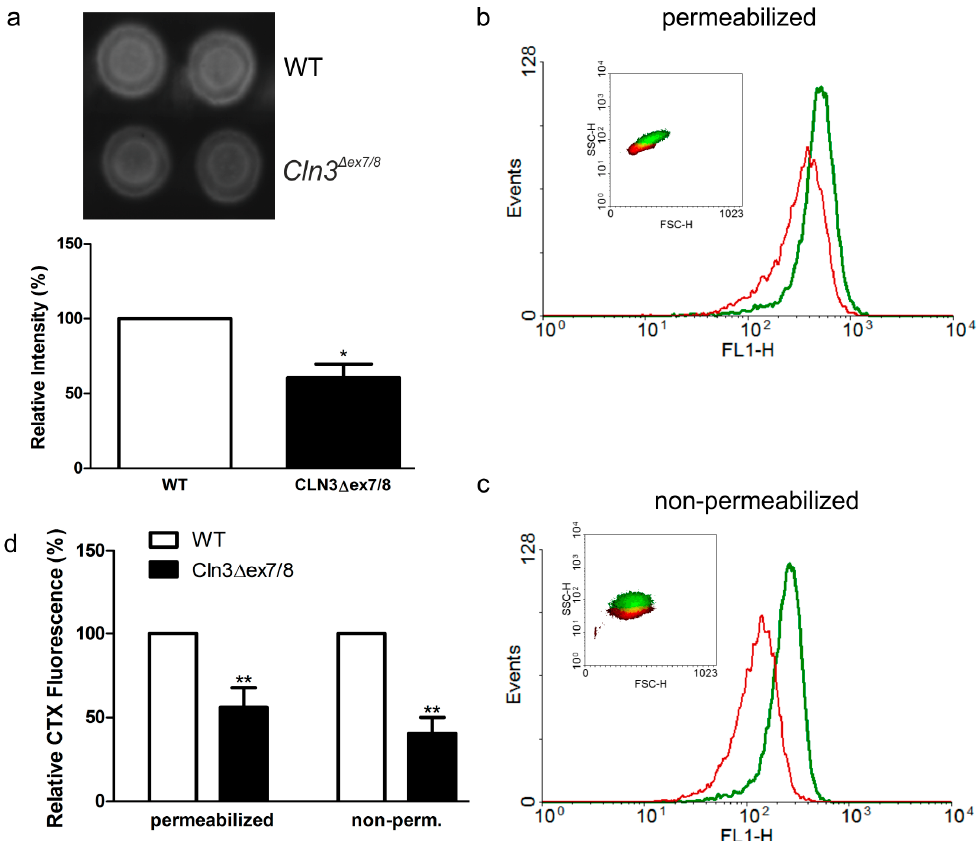
Figure 3. Reduced binding of cholera toxin on Cln3 Δ ex7/8 cells by dot blot and FACS analysis. ( a ) Dot blot of cholera toxin (CTX) binding to WT or Cln3 Δ ex7/8 cell lysates. Equal amounts of total protein from cell lysates were dot blotted onto nitrocellulose membrane that was incubated with HRP-coupled CTX. The signal was detected using enhanced chemiluminescence and quantified. Representative fluorescence intensity profiles of ( b ) permeabilized or ( c ) non-permeabilized WT (green) and Cln3 ∆ ex7/8 (red) cells. The cells were incubated with FITC-coupled CTX to detect surface and intracellular GM1a pools and analyzed by flow cytometry. Insets in ( b , c ) represent associated forward and side-scatter plots to demonstrate size distributions of WT (green) and Cln3 ∆ ex7/8 cells (red). ( d ) Quantification of the flow cytometry data from four independent experiments shows a significant reduction of CTX-FITC binding in both permeabilized and non-permeabilized Cln3 ∆ ex7/8 cells. Significance in ( a , d ) was assessed using Student’s t test. * p < 0.05; ** p < 0.01.